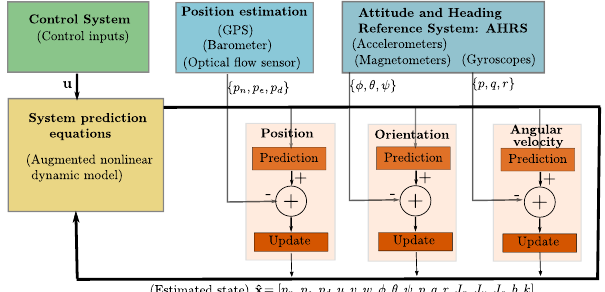
Figure 3. Diagram of the EKF in Configuration (b) .